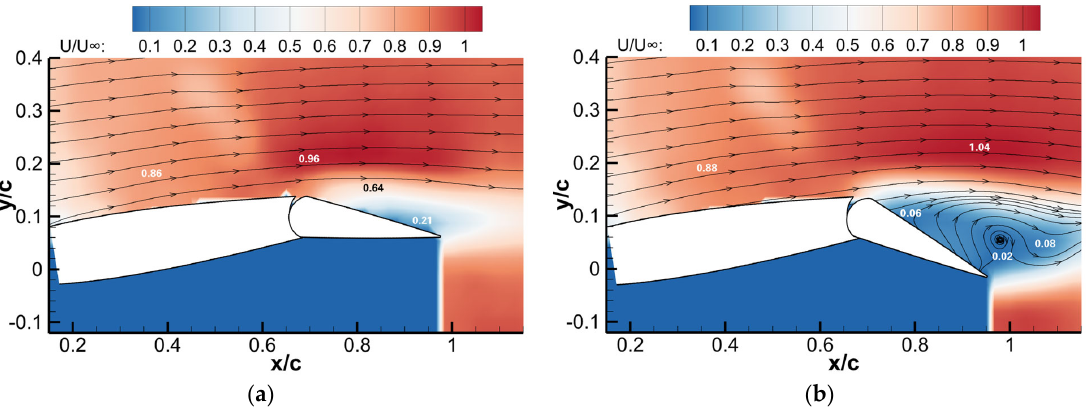
Figure 11. Velocity cloud diagram and streamline diagram of vertical tail upper surface without control: ( a ) δ = 15°; ( b ) δ = 30° ( β = − 10°, Re = 2.12 × 10 5